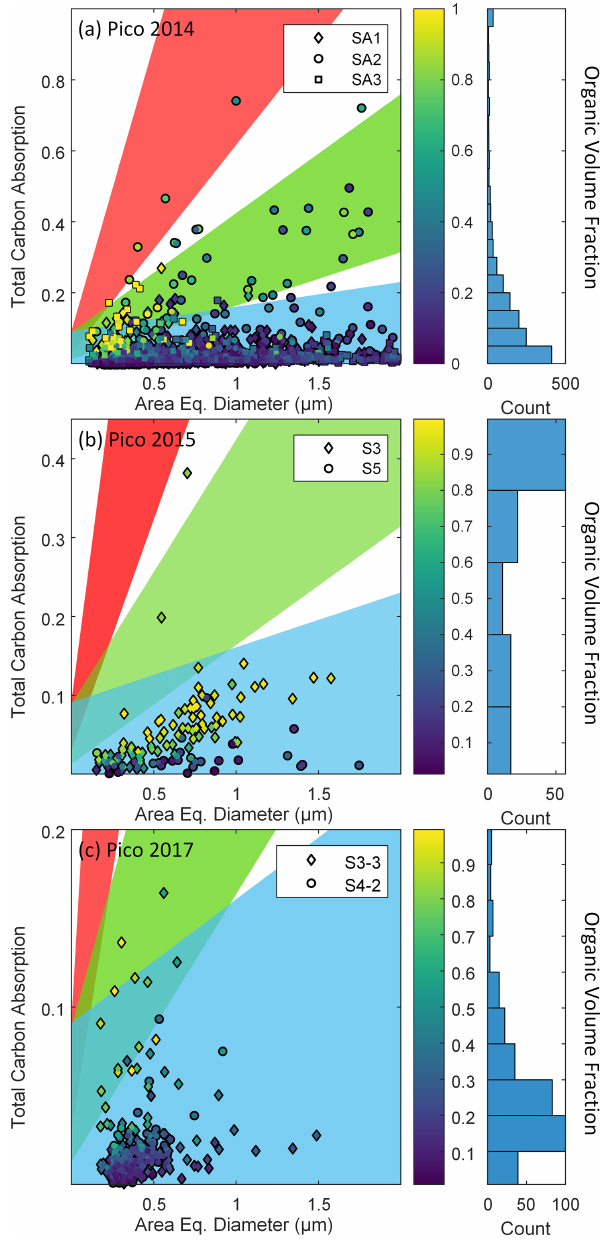
Figure 6. Total carbon absorption (TCA) as a function of area- equivalent diameter of the impacting particle (a) and histogram plots of TCA from (a) Pico 2014, (b) Pico 2015, and (c) Pico 2017. Symbols are colored by organic volume fraction (retrieved from STXM-NEXAFS measurements). Shaded areas represent different phase-state regions (liquid: blue, semisolid: green, and solid: red). Side plots are histograms of the organic volume